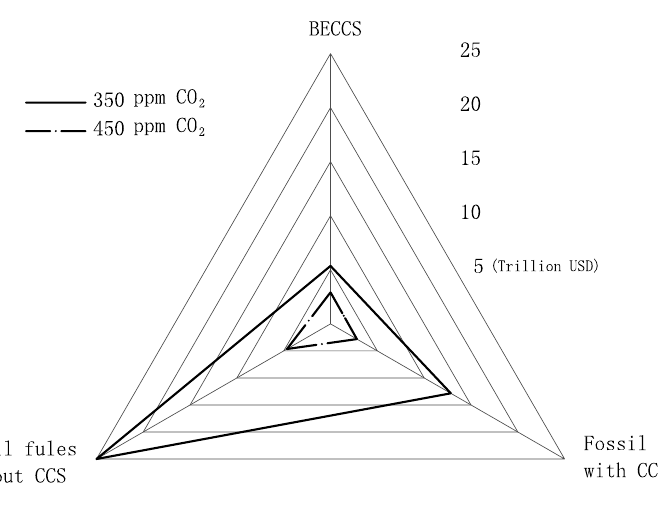
Figure 15. Comparison of bioenergy with CCS (BECCS) and conventional fossil fuel combustion.